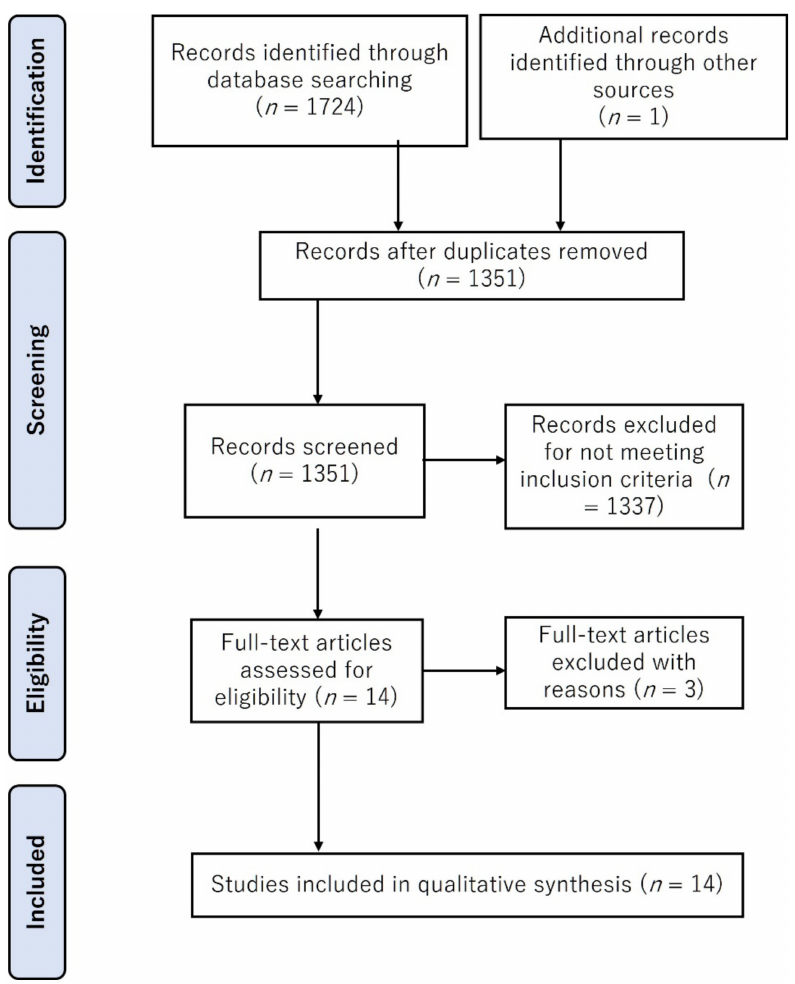
Figure 1. Flow diagram outlining steps for study inclusion/exclusion in this